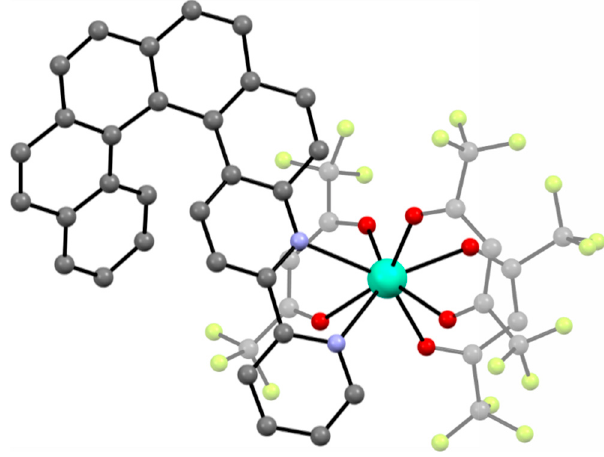
Figure 2. The crystal structure of [Dy(hfac) 3 (L1)] ( 1 ) as the representative example of the isostructural series [Ln(hfac) 3 (L1)] (Ln = Dy for 1 , Y for 5 , Eu for 6 , Gd for 7 and Yb for 8 ). Dy—teal, O—red, C—gray, N— blue, F—bright yellow.